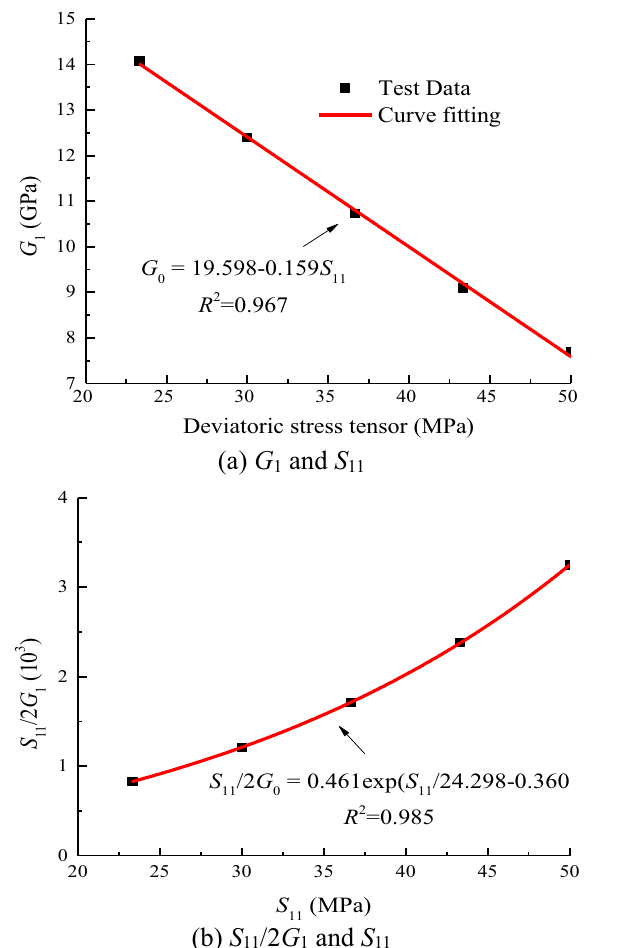
Figure 9. Data fitting of G 1 when σ 3 = 15